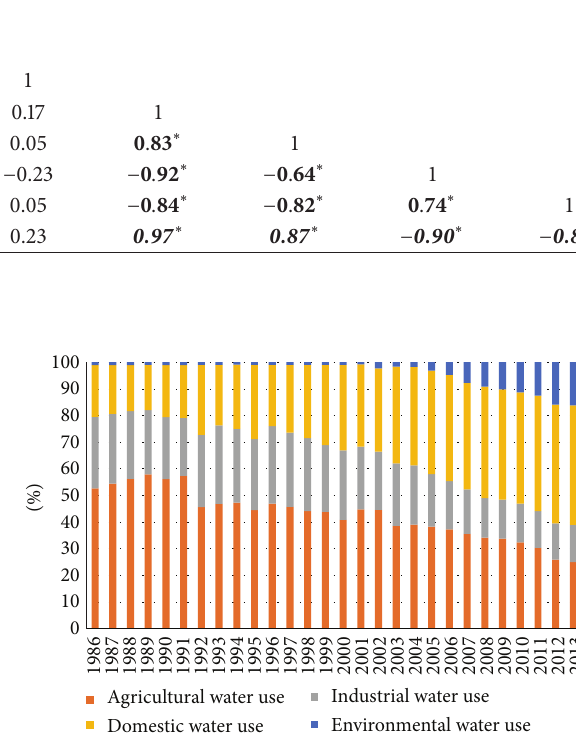
Figure 6: Water consumption composition in Beijing from 1980